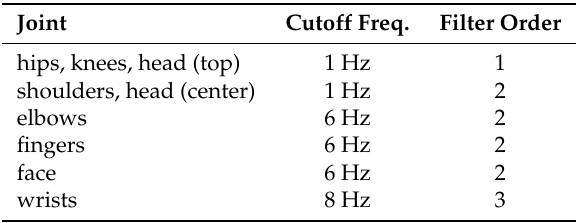
Table 1. Different Butterworth filter settings are used to smooth the joint position data obtained using OpenPose. Joint Cutoff Freq. Filter Order hips, knees, head (top) 1 Hz 1 shoulders, head (center) 1 Hz 2 6